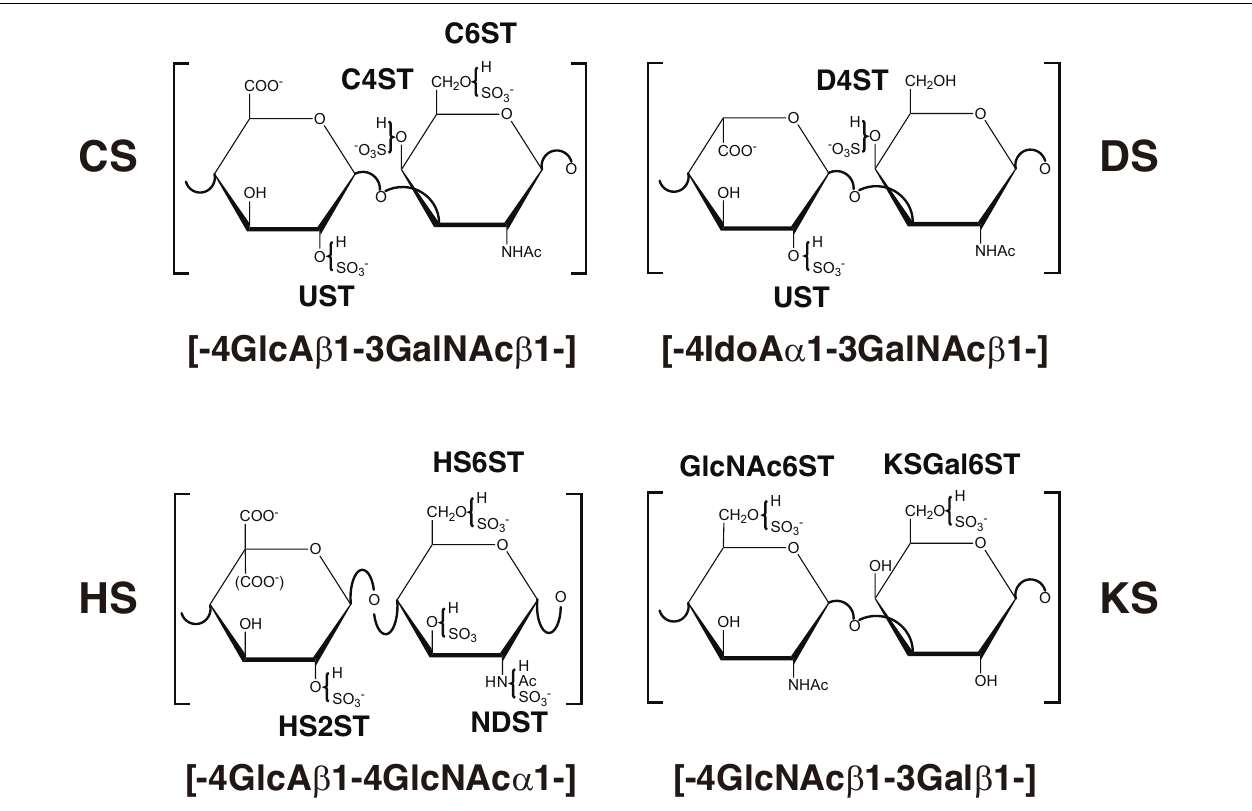
FIGURE 3 | Typical repeating disaccharide units in GAGs and the respective sulfotransferase. The CS backbone consists of GlcA and GalNAc, whereas DS is a stereoisomer of CS that includes IdoA instead of GlcA. HS consist of uronic acids (IdoA and GlcA) and GlcNAc/GlcNH 2 residues with varying proportions of IdoA and GlcA. These sugar residues can be esterified by sulfate at various positions as indicated in the figure by action of the respective sulfotransferase, which transfers the sulfate group from the sulfate donor 3 (cid:48) -phosphoadenosine 5 (cid:48) -phosphosulfate (PAPS) to the respective hydroxygroup of each residue.